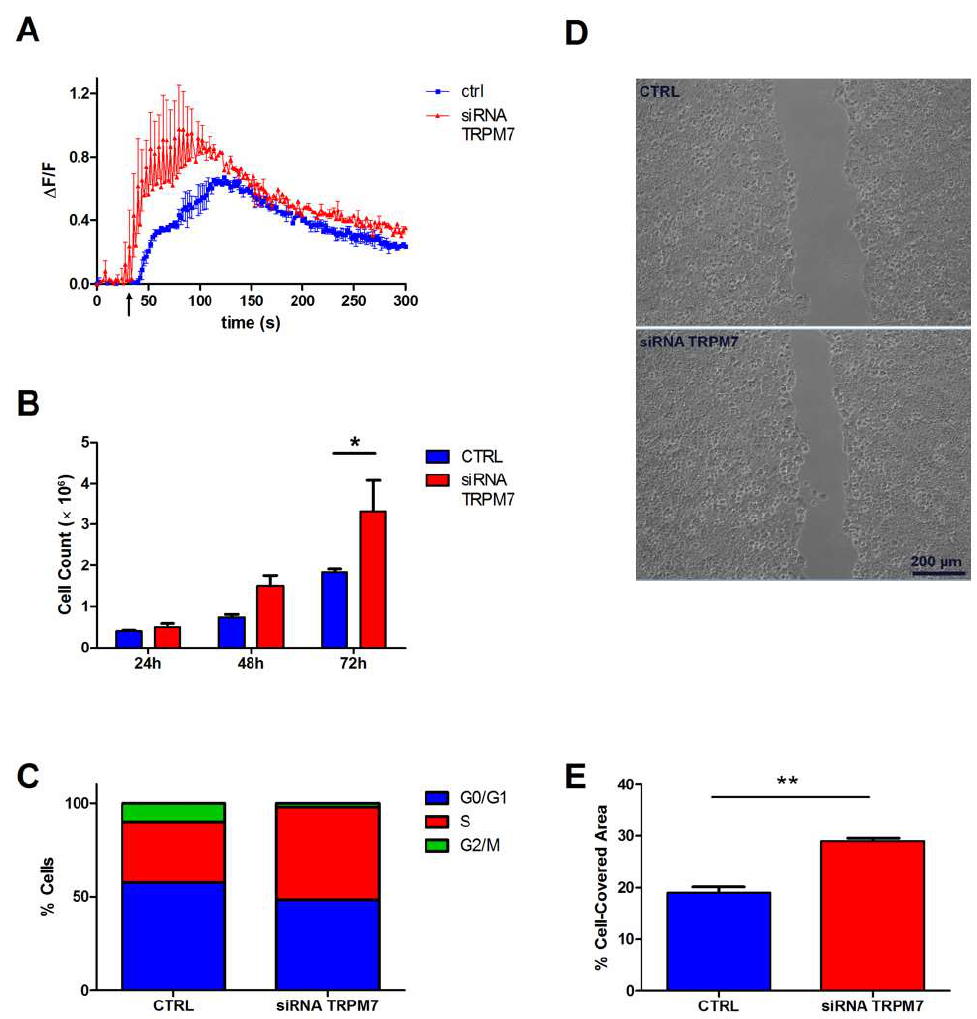
Figure 3. Contribution of TRPM7 to Mg 2+ influx and Mg-dependent colon cell functions. HT29 cells were transiently silenced for TRPM7 as detailed in Materials and Methods. For HCT116 cells, see Figure S2. ( A ) Mg 2+ influx capacity, as assessed 72 h after siRNA transfection. Mag-Fluo-4-loaded cells were challenged with 20 mM Mg (arrow) and time course of single-cell fluorescence was followed by live confocal imaging. The mean fluorescence (ΔF/F) of 10 cells ± standard error (SE) from a representative experiment is reported ( n = 3). ( B ) Cell proliferation. Cells were counted at the indicated times after siRNA transfection; mean ± SE of three independent experiments is shown. ( C ) Cell cycle distribution, as assessed 72 h after siRNA transfection. The percentage of cells in each phase was evaluated by flow cytometry; results are from a representative experiment ( n = 3). ( D ) Cell migration. Cells were silenced and grown to confluence in well inserts for 24 h. Insert removal created a 500-μm-wide cell-free gap, whose closure was monitored by microscopy. Representative images of the wound after 24 h in CTRL and siRNA TRPM7 cells are shown. ( E ) Cell migration. Quantification of the cell-covered area from three independent wound healing assays. Results are expressed as the percentage of the initial gap area that was covered by cells after 24 h. * p < 0.05, ** p < 0.01 by unpaired Student’s t test.